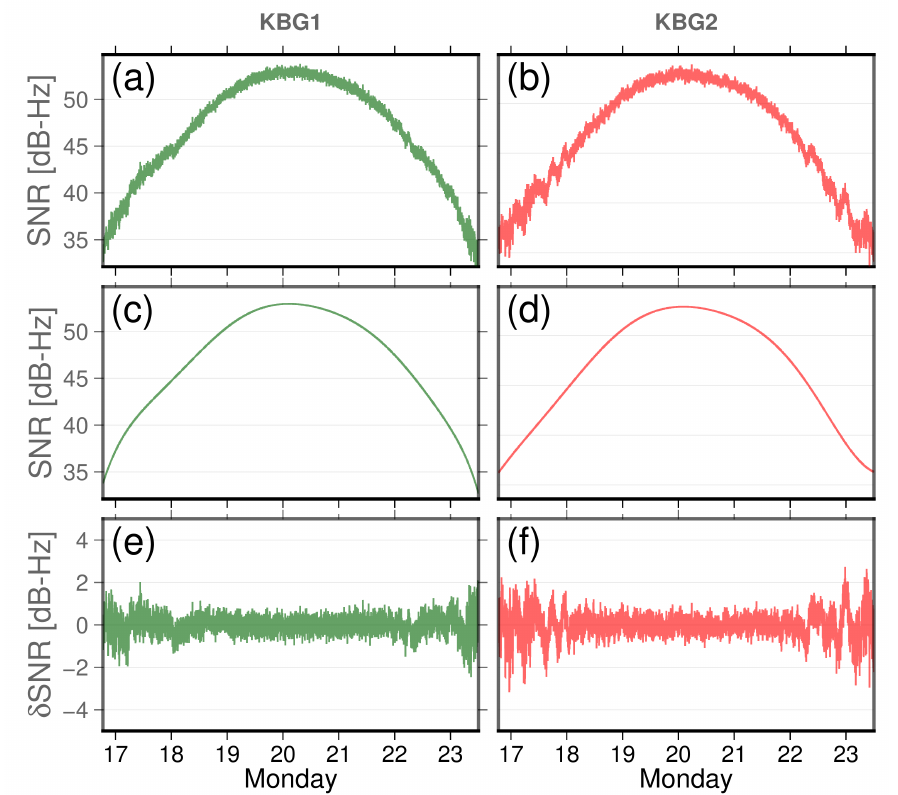
Figure 13. Raw SNR time series where the direct and indirect signals are superimposed as observed by the Alloy Trimble reference receiver for the L1, the GPS signal on 1 March, for GPS satellite PRN27. ( a ) Raw SNR as recorded by station KBG1. ( b ) Raw SNR as recorded by station KBG2, where the direct signal for both stations dominates the main signal. We have applied the ninth-order polynomial as depicted in ( c ) for KBG1 and ( d ) for KBG2. After subtracting the polynomial fit of the model from the raw SNR values, δ SNR is shown in ( e ) for KBG1 and ( f ) for KBG2. Horizontal axes are the time of day in units of hours. The vertical axes are SNRs in units of